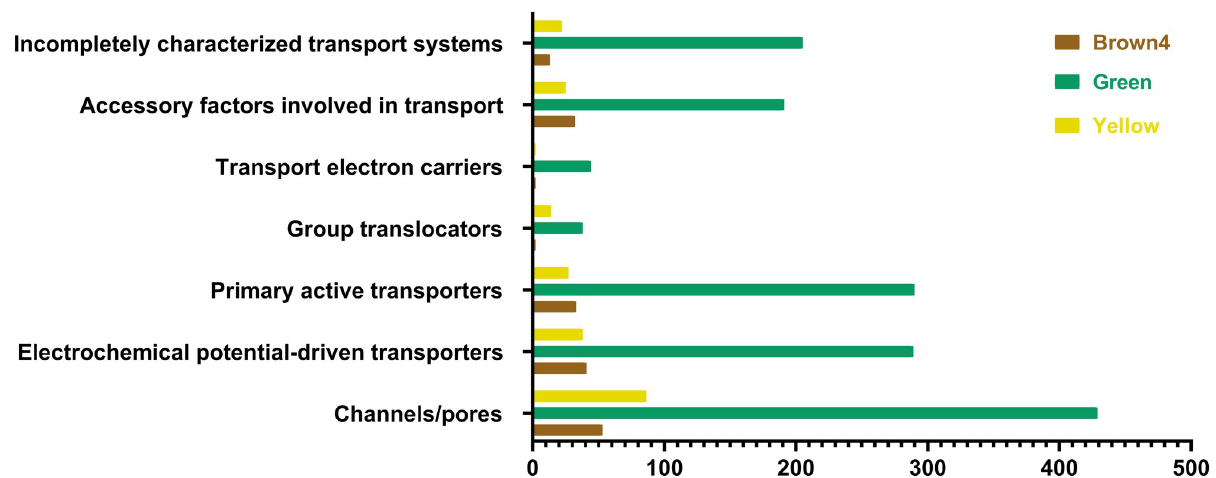
Fig 3. Transporter systems in selected modules of R . officinalis . Y-axis shows the transporter systems and x-axis shows the number of unigenes.